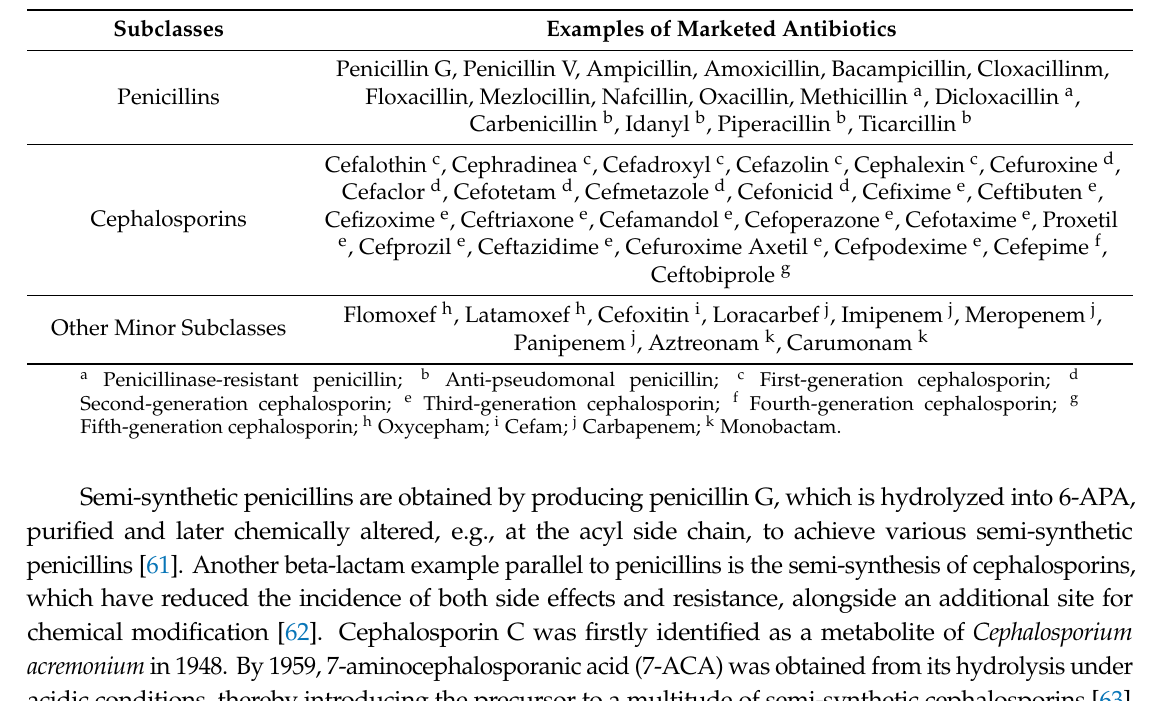
Table 1. Beta-lactam subclasses highlighting their diversity with examples of marketed